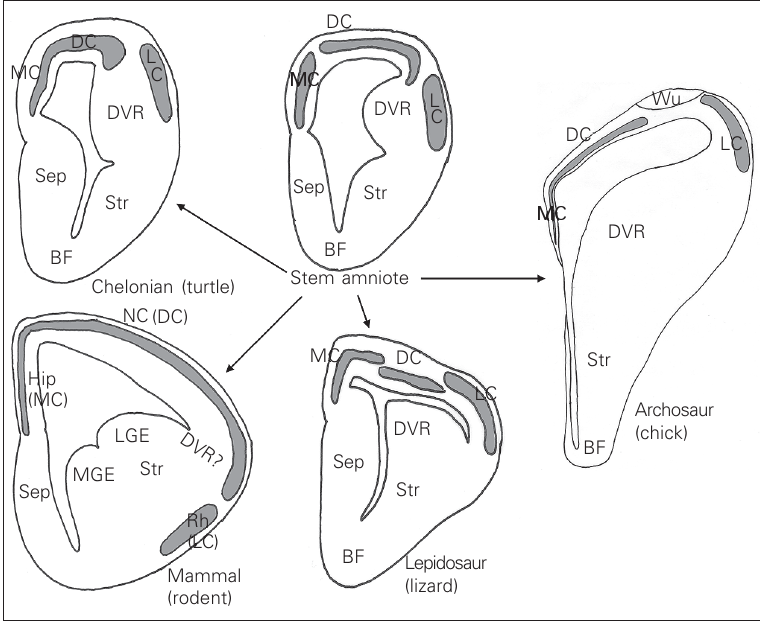
Figure 2. Overview of cortical organization in the different amniotes, with inference of